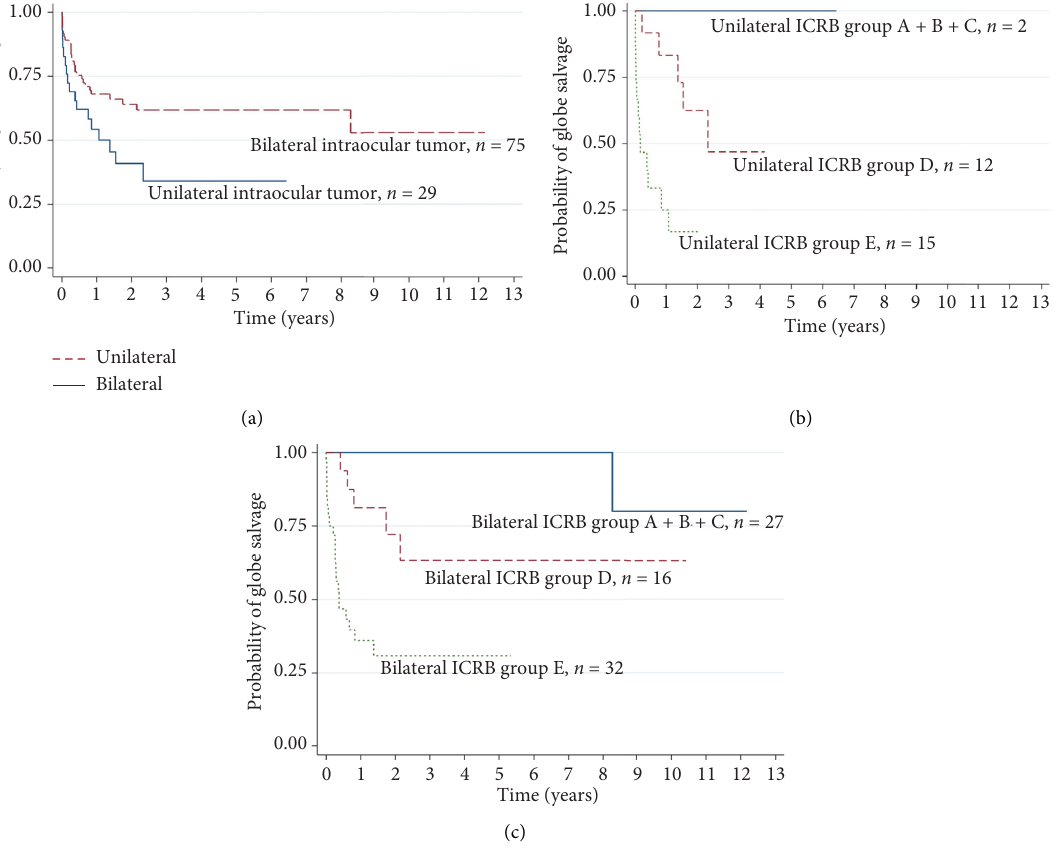
Figure 1: Kaplan–Meier survival analysis of globe salvage in intraocular tumors: (a) including all eyes (unilateral vs. bilateral); (b, c) unilateral and bilateral: based on the International Classification of Retinoblastoma